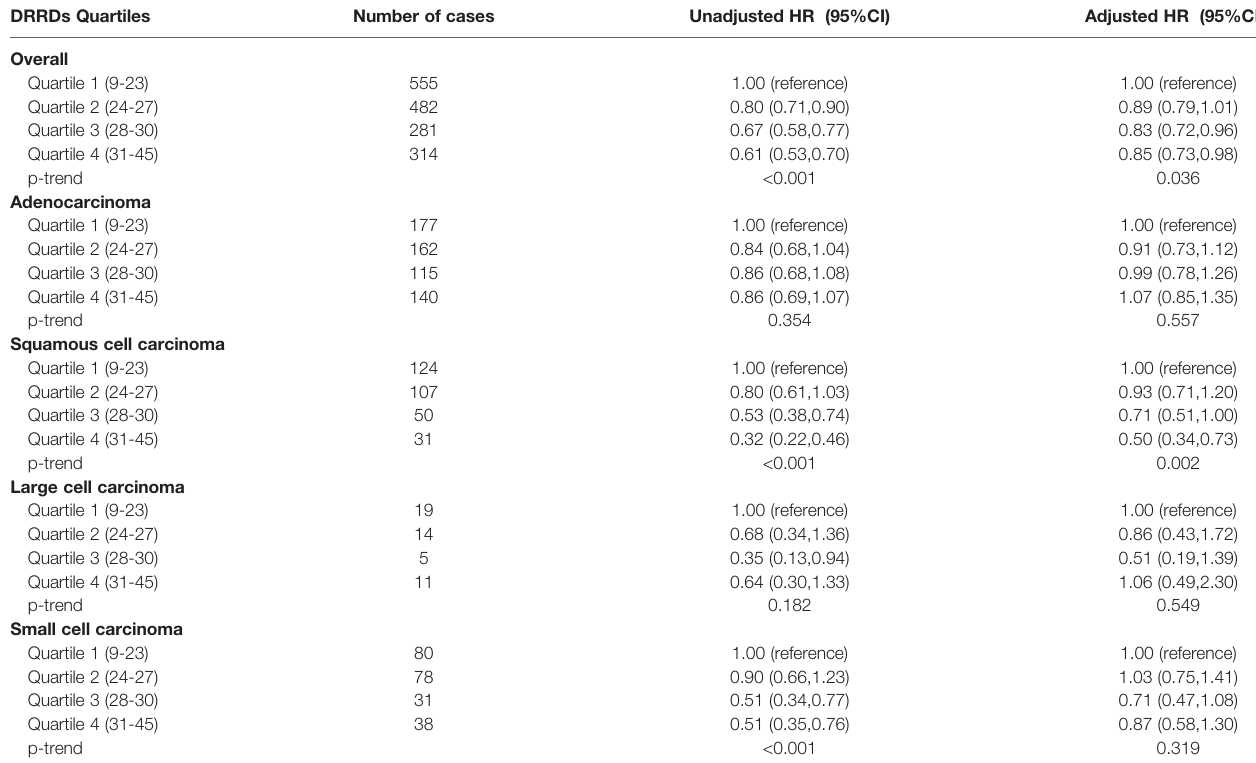
TABLE 2 | HRs of the association between DRRD score and the incidence of lung cancer and sub-histology types. DRRDs Quartiles Number of cases Overall Quartile 1 (9-23)